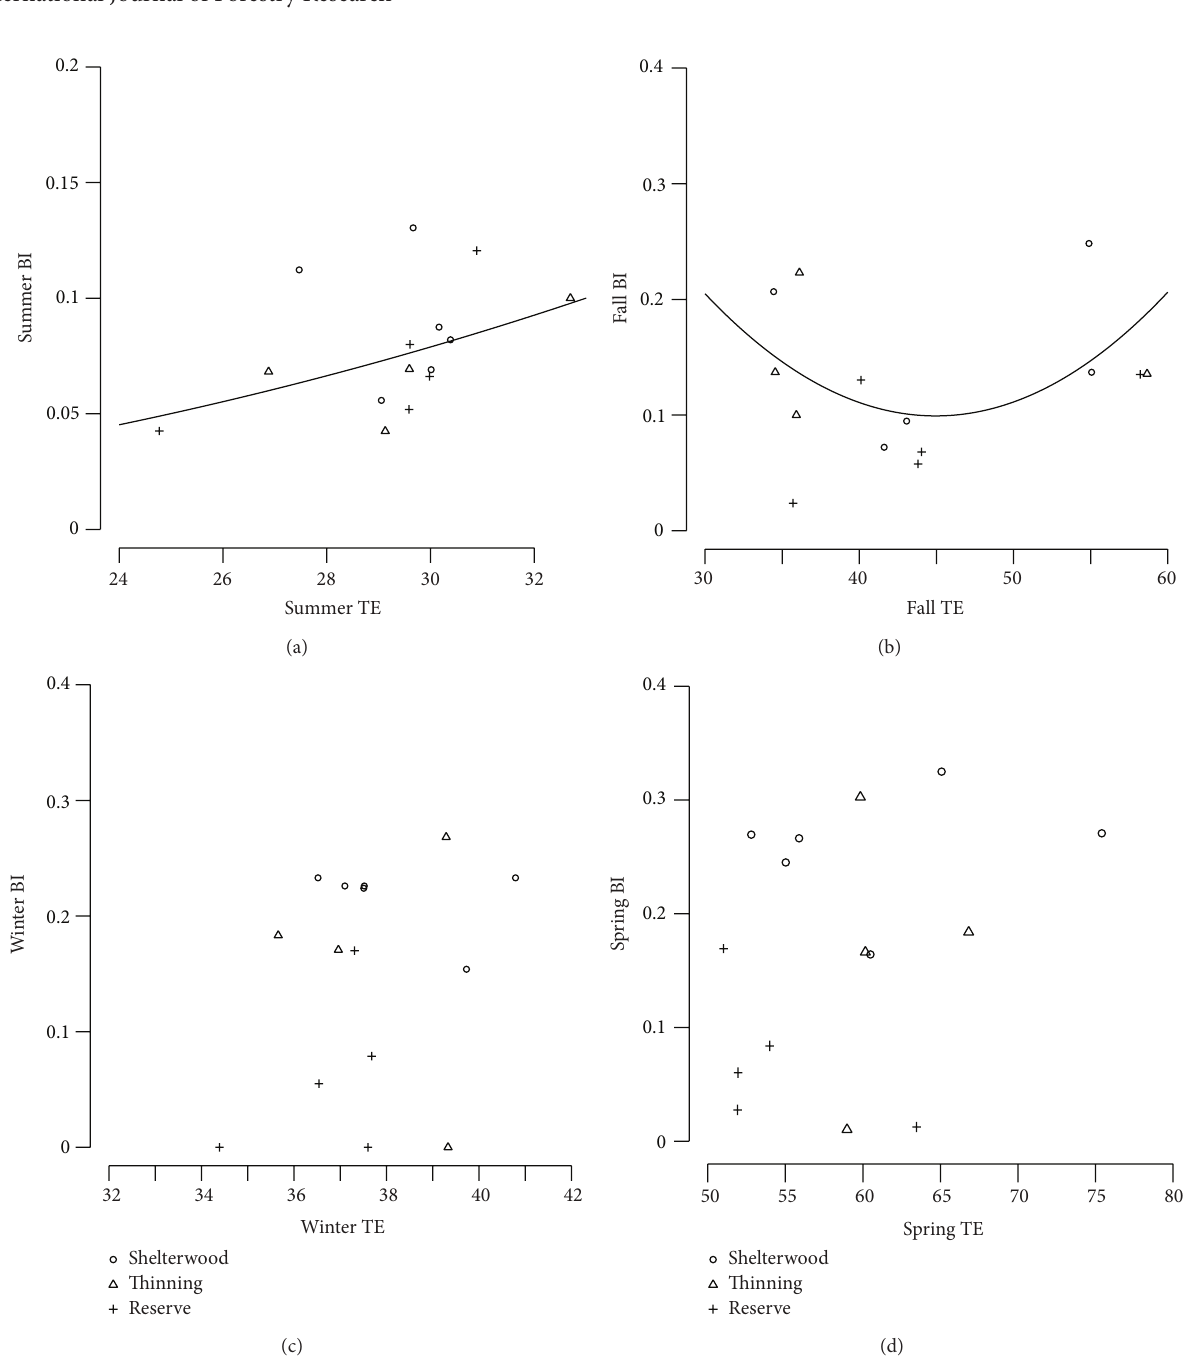
Figure 3: Relationship between the thermal environment ( 𝑇𝐸 ) and browse index (BI) at YMF for (a) the summer (May–August), (b) fall (September–October), (c) winter (November–January), and (d) spring seasons (February-March). Regression lines are provided when significant models were